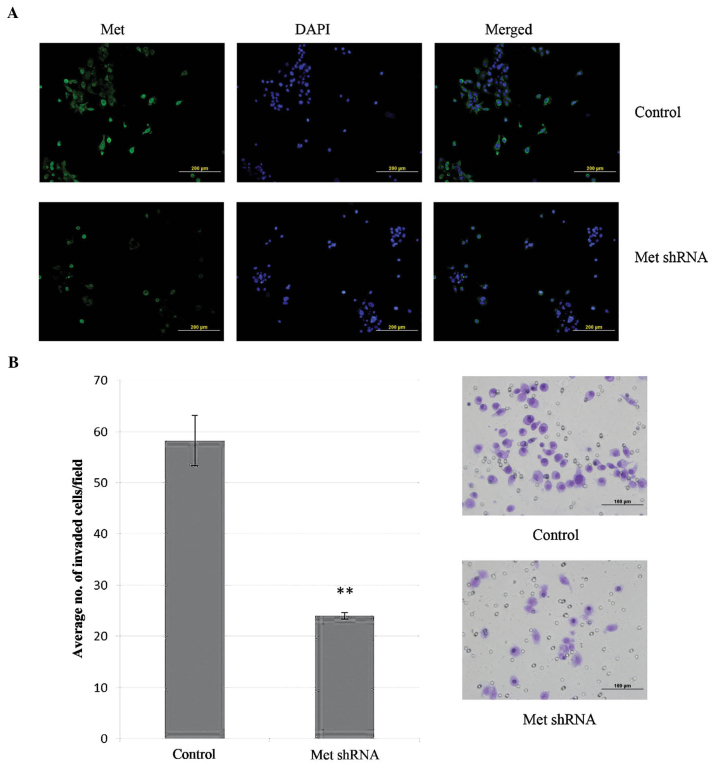
Effect of inhibition of Met expression on RMCCA-1 invasion under hypoxia. (A) Immunofluorescence staining of Met protein in RMCCA-1 cells (scale bar, 100 µm). (B) Cell invasion capabilities after treatment with Met shRNA vs. control under hypoxic conditions (scale bar, 100 µm). Values are expressed as the mean ± standard deviation. **P<0.001 vs. control. shRNA, small hairpin RNA; Met, hepatocyte growth factor receptor.